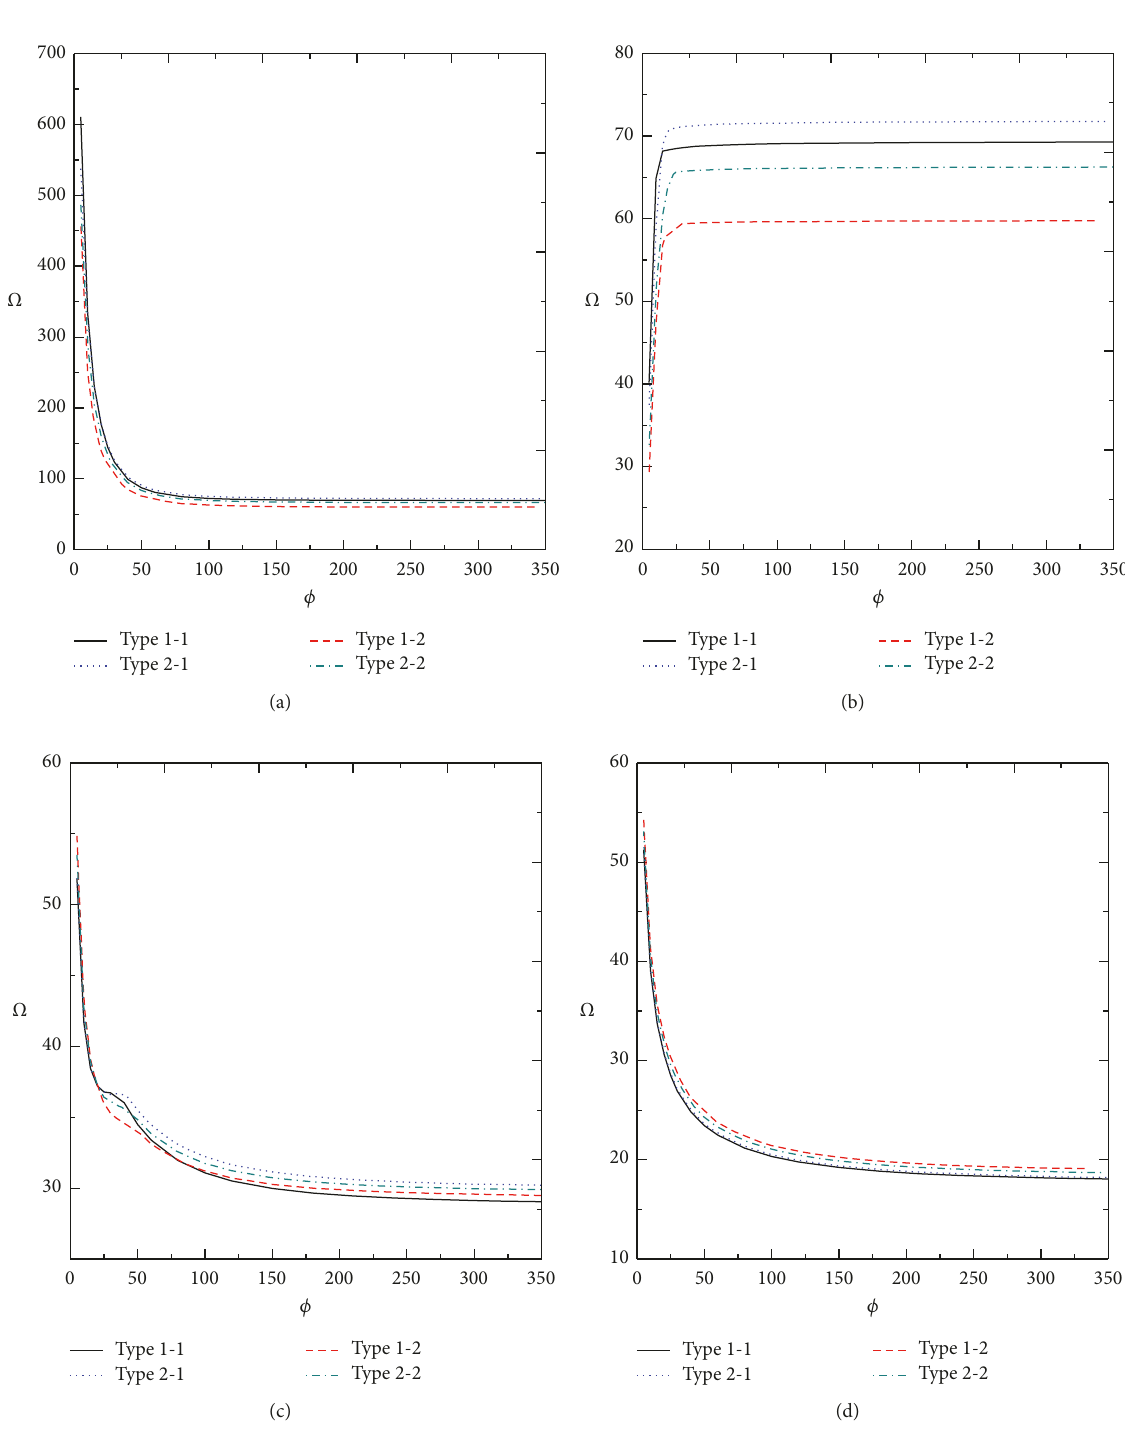
Figure 11: Variations of fundamental frequency parameter Ω of annular sector plate against different sector angles ( 𝑅 0 /𝑅 1 = 0.5, 𝜙 = 120 ∘ , ℎ/𝑅 𝑝 1 = 𝑝 3 = 5): (a) CCCC; (b) CFCF; (c) CE 1 E 1 E 1 ; (d) E 3 E 3 E 3 E 3 1 = 0.2, and